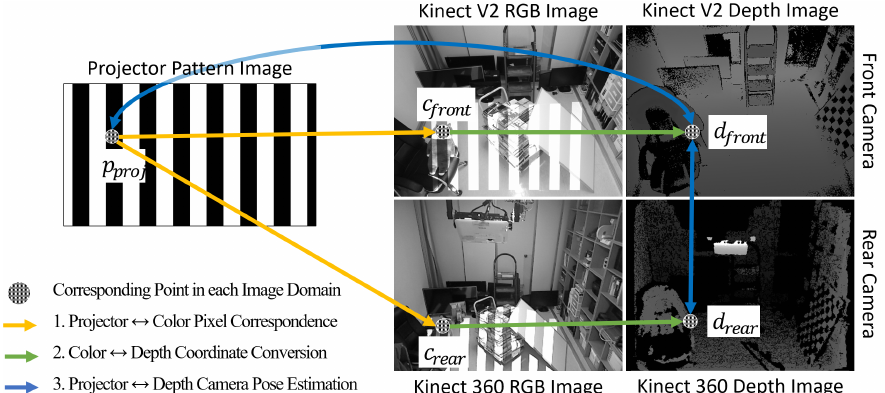
Figure 2. Computing pixel correspondences between cameras and a projector with gray code patterns. First, the pixel correspondences between the projector and both front and rear RGB-D cameras are computed. Then, corresponding points in the color images are transformed to depth image points. Finally, the depth image points are un-projected to 3D points, which are used to calibrate the projector and between front and rear cameras.